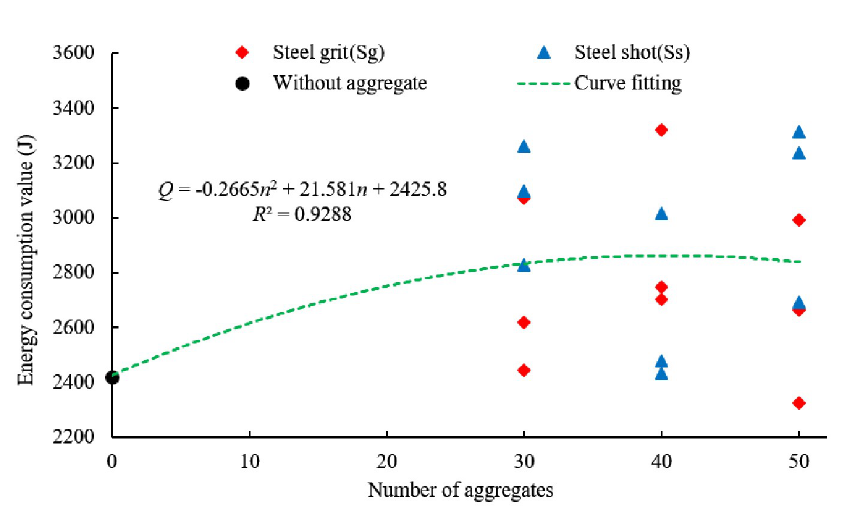
Fig 16. Energy consumption and fitting curve for aggregate